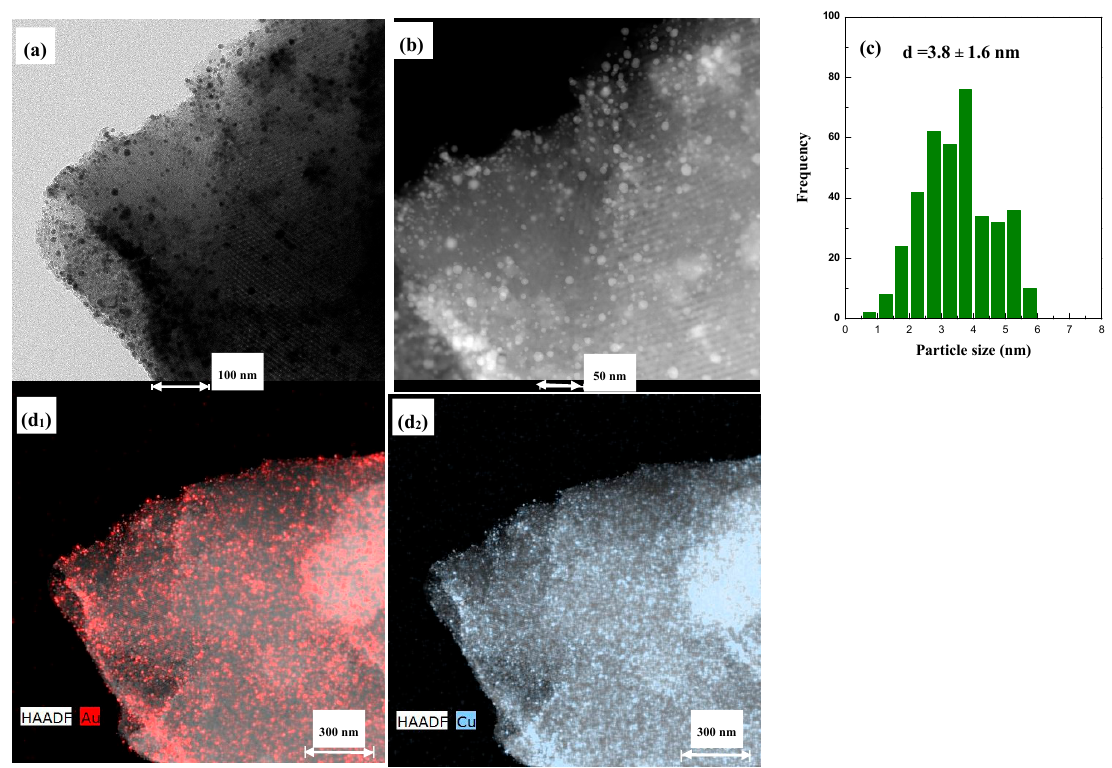
Figure 7. ( a ) TEM, ( b ) STEM, ( c ) particle size distribution and ( d i ) mapping results for AuCu/Ti-SBA sample.